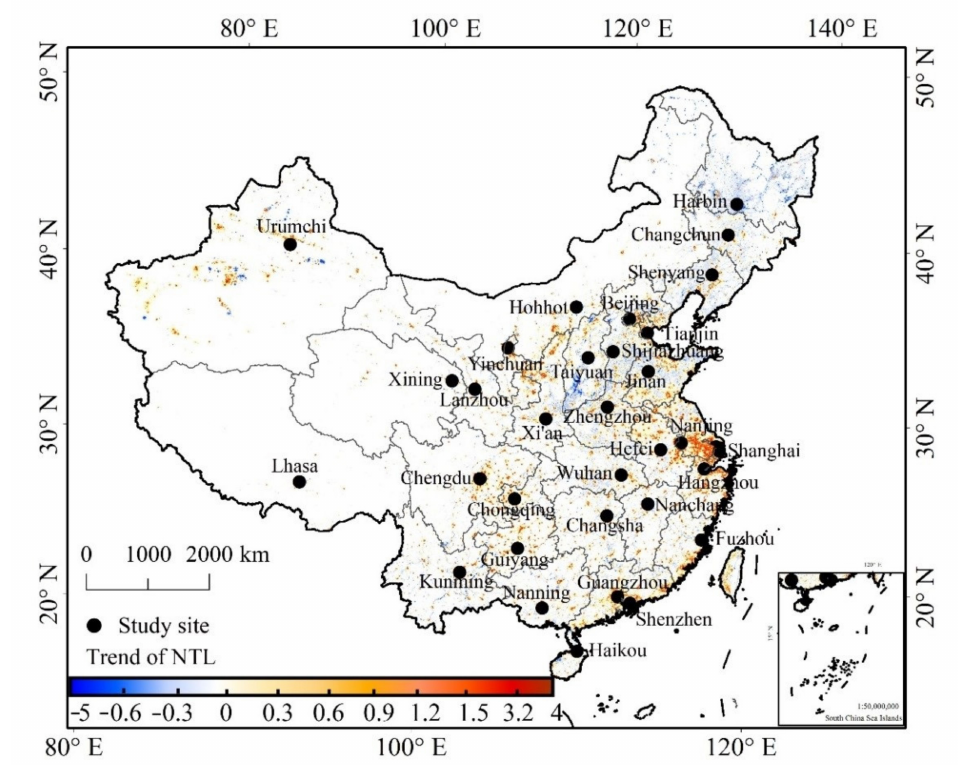
Figure 6. Spatial distribution map of the NTL change trend from 2001 to 2018.